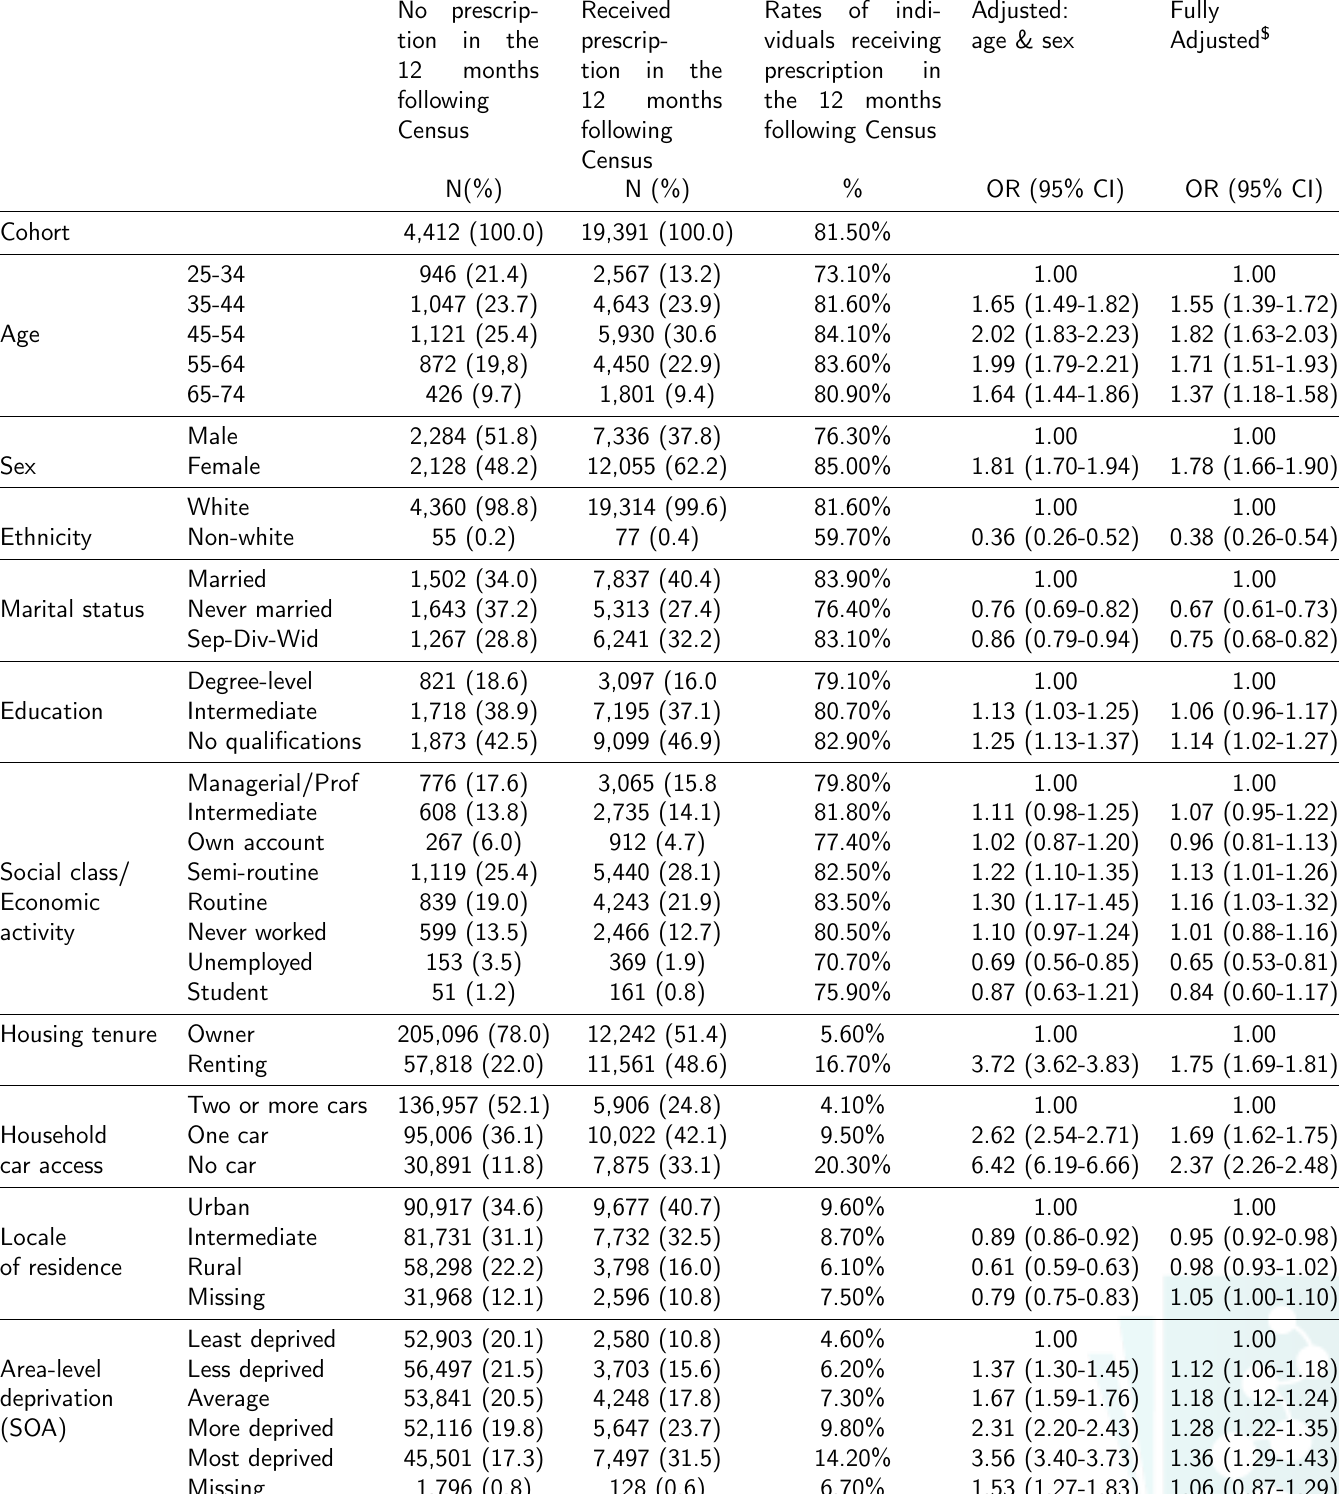
Table 1: Characteristics of persons 25-74 and likelihood of reporting mental health problems at Census. Data represent numbers (percentages) and Odds Ratios (95% Confidence Intervals) from logistic regression